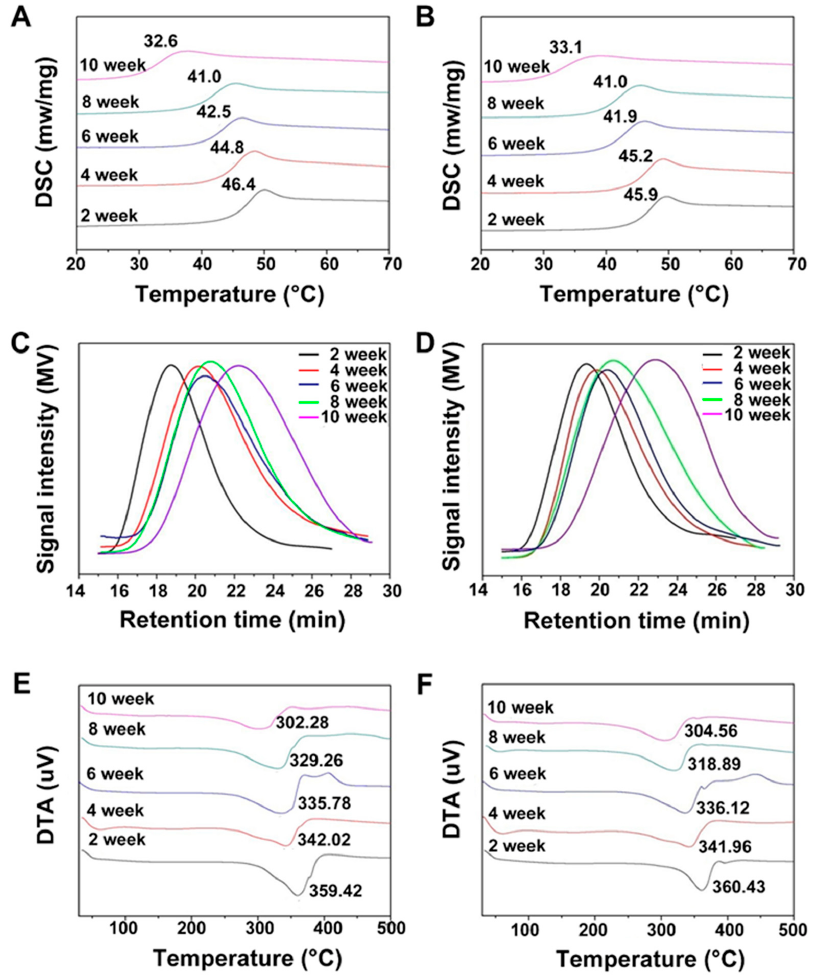
Figure 6. ( A , B ) DSC curves, ( C , D ) molecular weight distribution, and ( E , F ) DTA curves of the